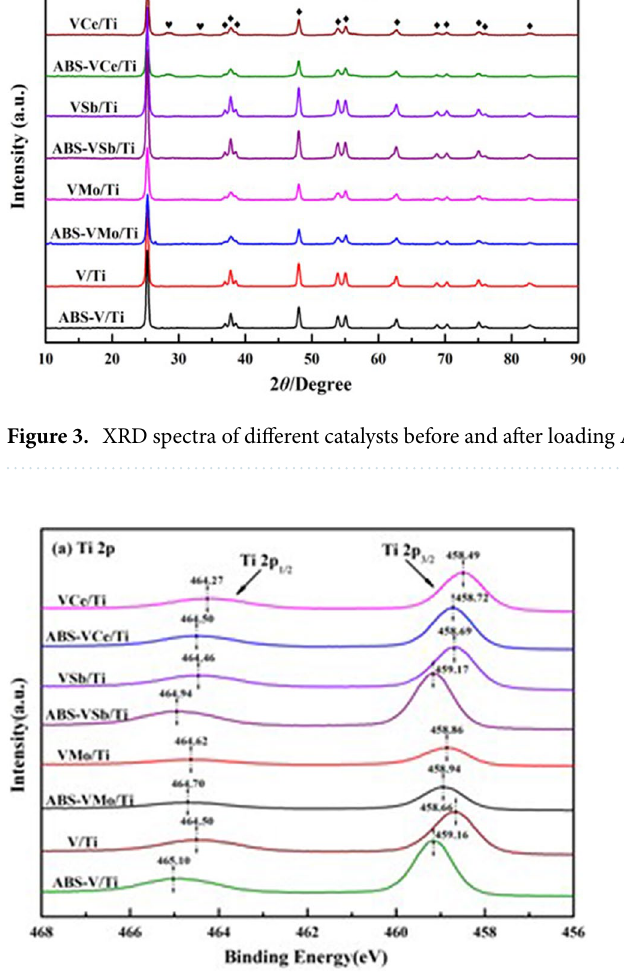
Figure 4. XPS spectra of Ti 2p orbitals of catalyst before and after loading ABS 4